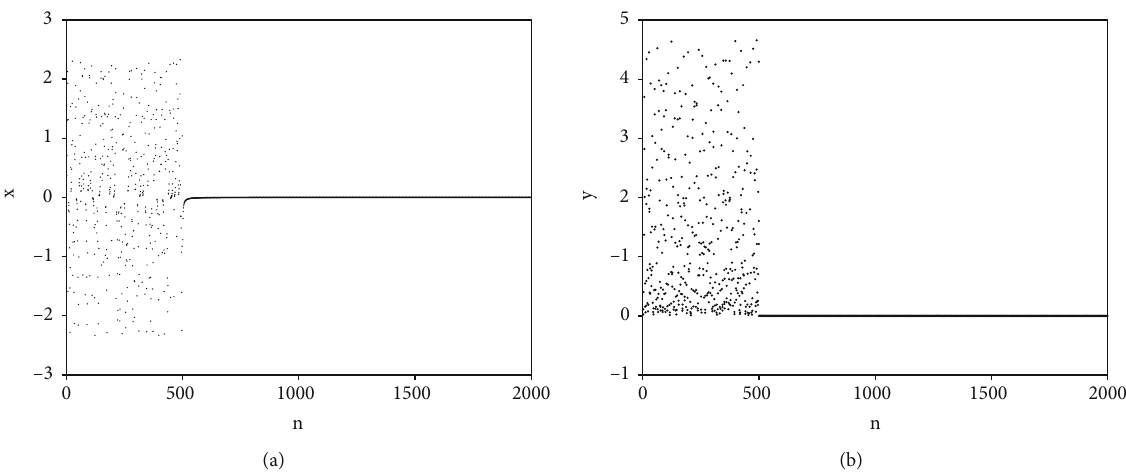
Figure 8: The controlled results for map (10). (a) The state variable x with n (b) the state variable y with n .